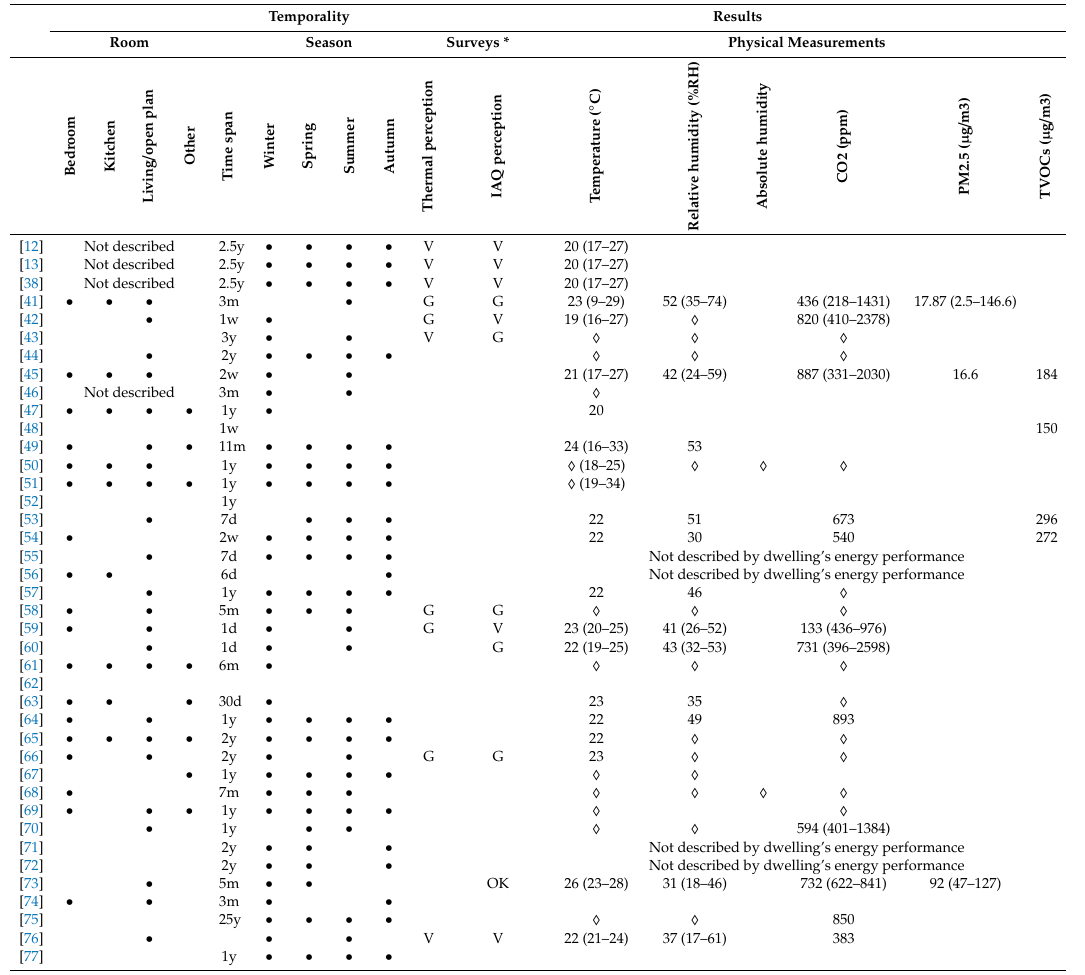
Table 3. Publications about IAQ in Passivhaus dwellings. Part